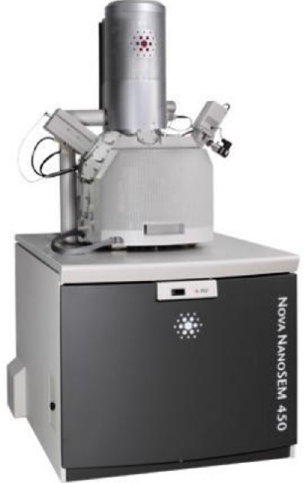
Fig. 18. Electron microscope.